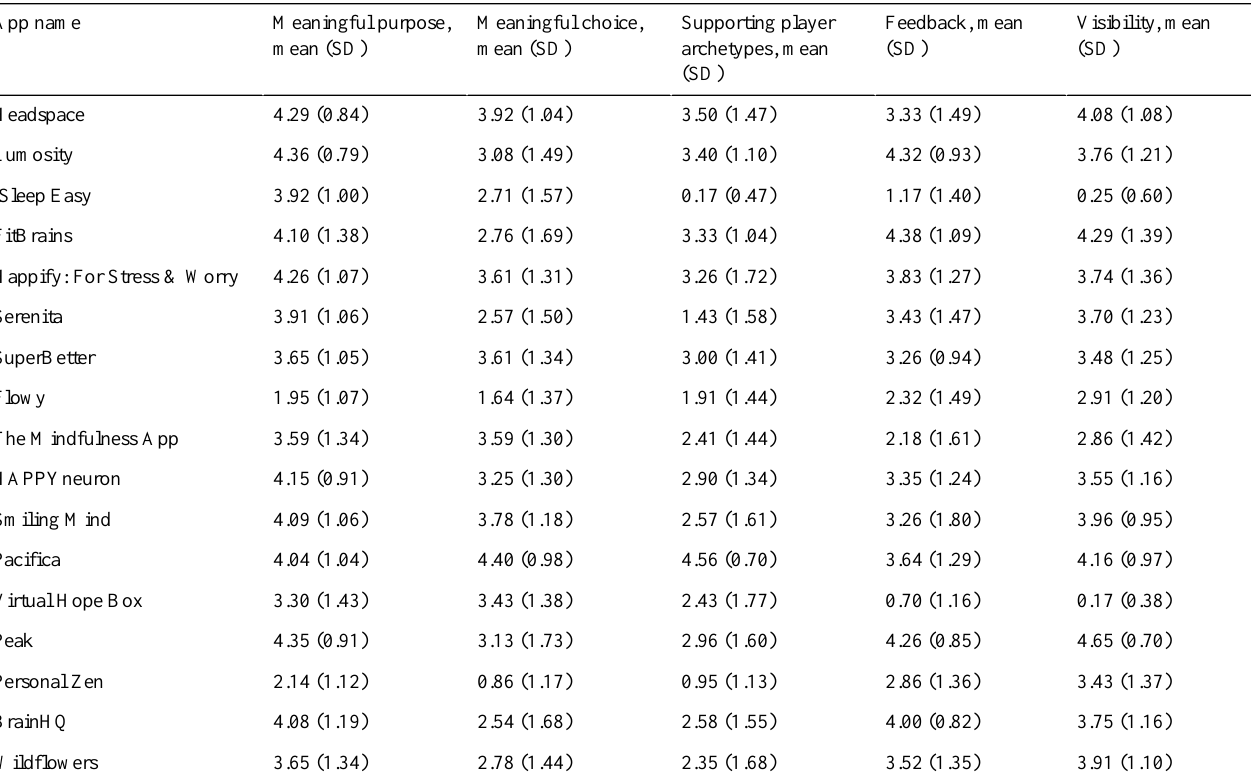
Table 2. Mean and SD ratings for each gamification principle across raters.